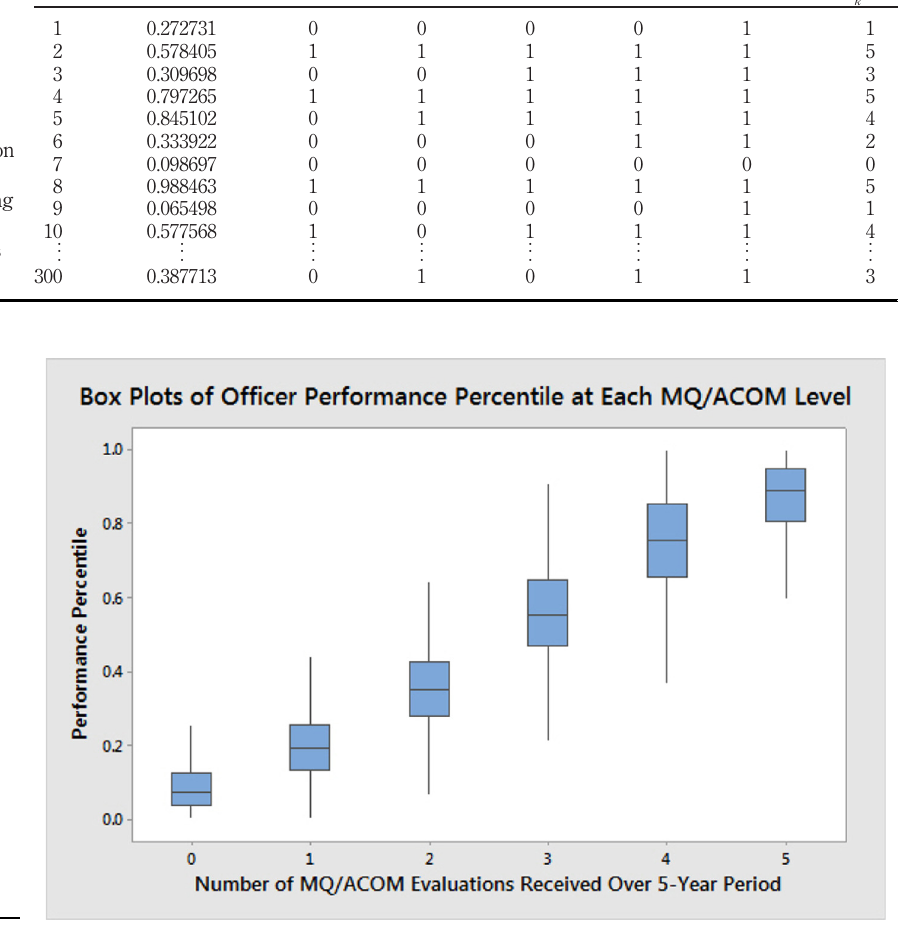
Figure 5. Performance percentile distribution for of fi cers receiving k MQ/ACOM